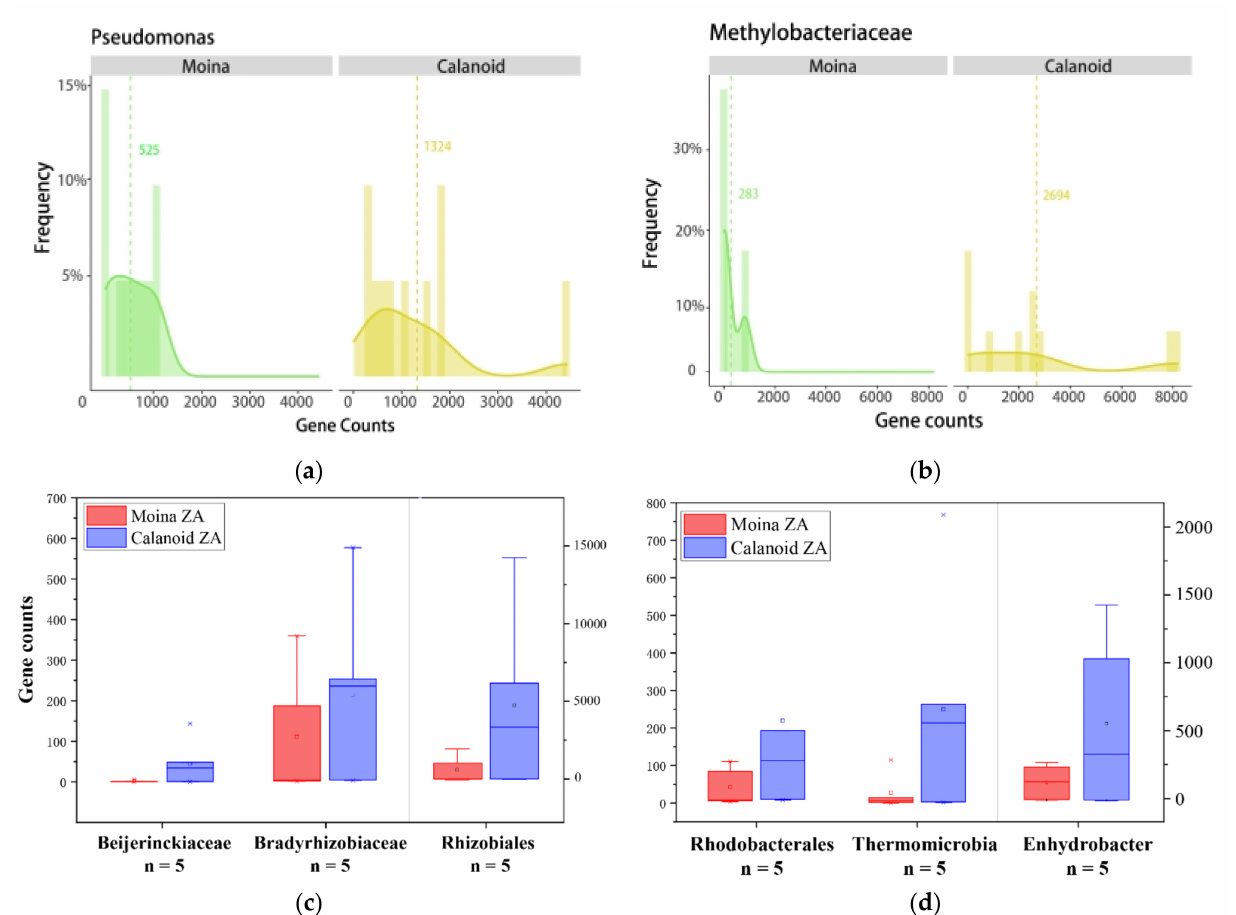
Figure 7. Reads of Pseudomonas (nitrogen reduction) and Methylobacteriaceae (carbon metabolism) associated with Moina and Calanoids from five freshwater lakes are respectively shown in ( a , b ). The dotted line to the right means higher read counts. Nitrogen fixing and facultative anaerobes are shown in ( c , d ). Lakes are listed as XXK, QK, XHL, QLJ, and